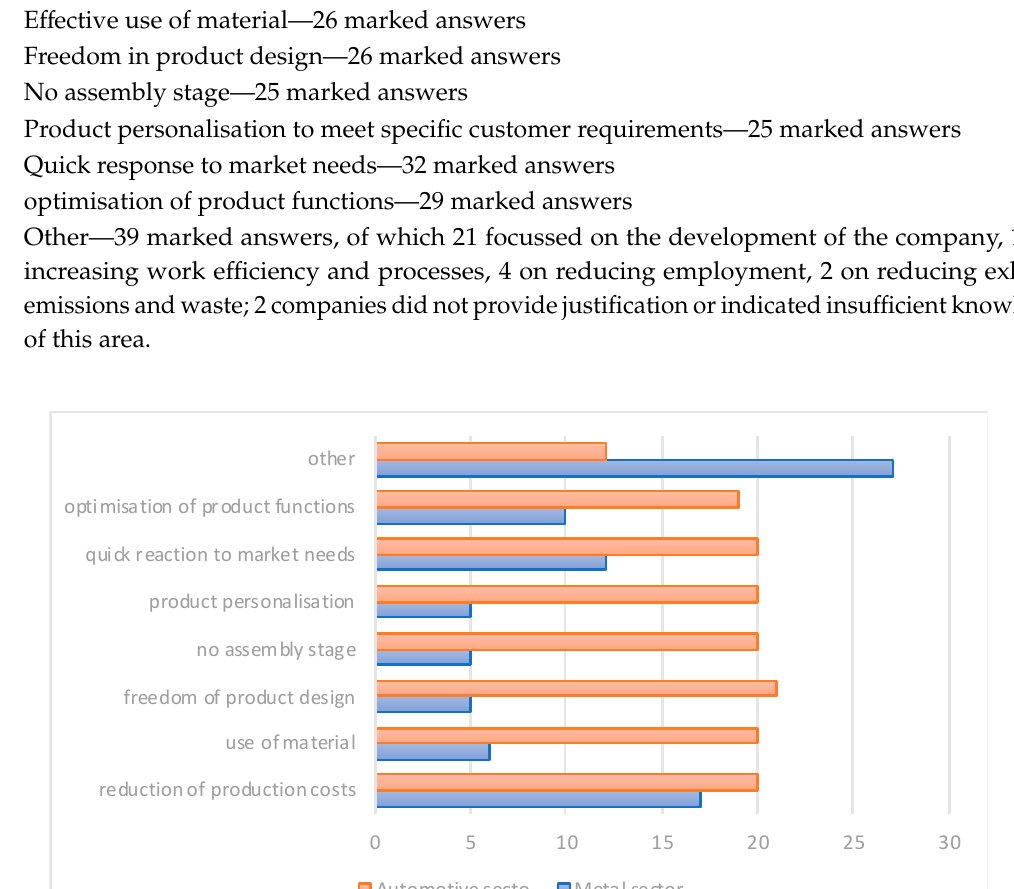
Figure 3. Interest in implementing AM. Answers declared by respondents from the automotive and metal industries.